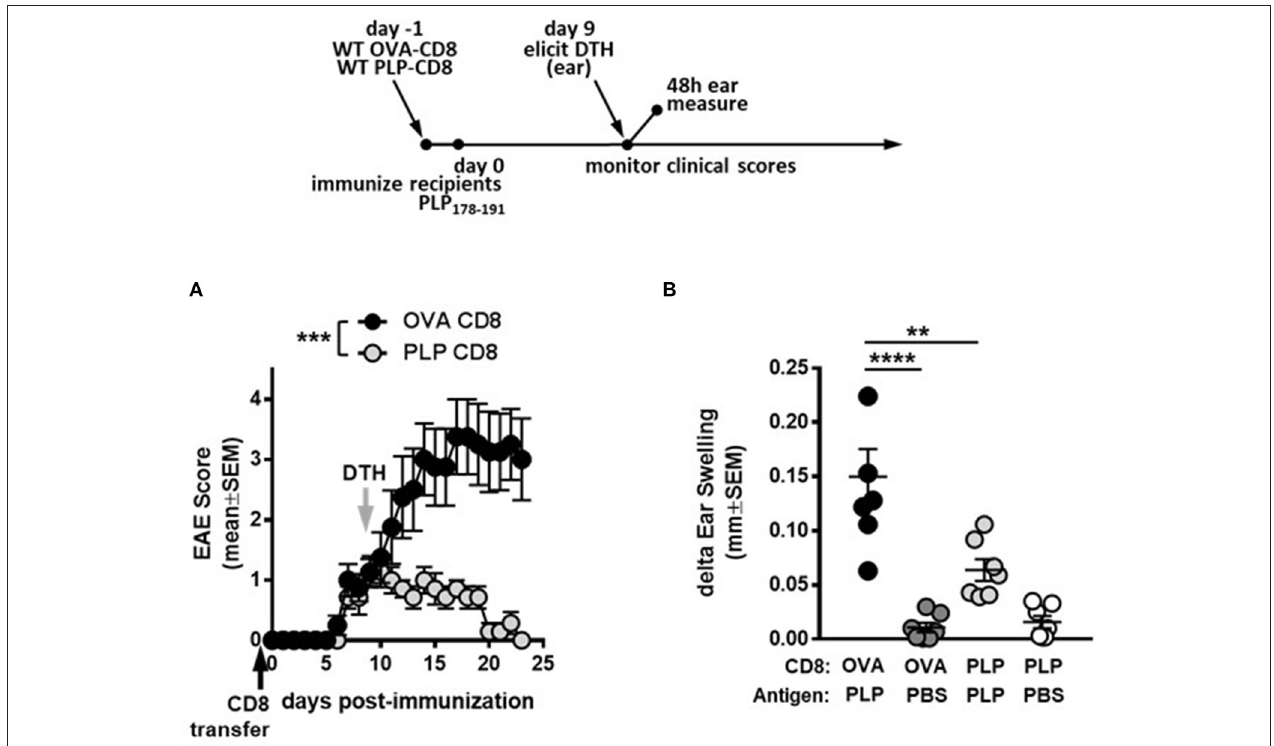
FIGURE 1 | PLP-specific CD8T cells suppress PLP-specific CD4T cell responses during demyelinating disease. (A) On day − 1 (black arrow), OVA-CD8 or PLP-CD8 were adoptively transferred to naïve recipients. The following day, mice were immunized with PLP178-191/CFA to induce EAE and disease scores were monitored. n = 7 per group. (B) On day 9 post-immunization (gray arrow in A) , ear pinnae were injected with either PLP178-191 peptide or vehicle control (PBS). Ear swelling was measured at 48h post-ear challenge. n = 7 per group. ** p < 0.01; *** p < 0.001; **** p <